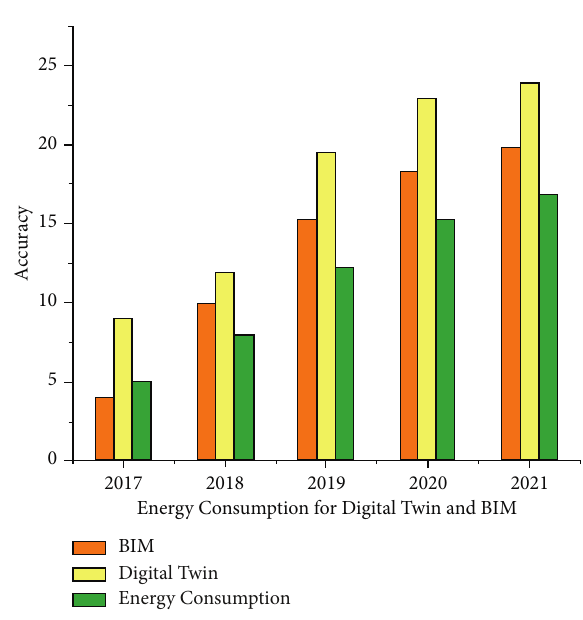
Figure 5: Energy consumption for Digital Twin and BIM using AI